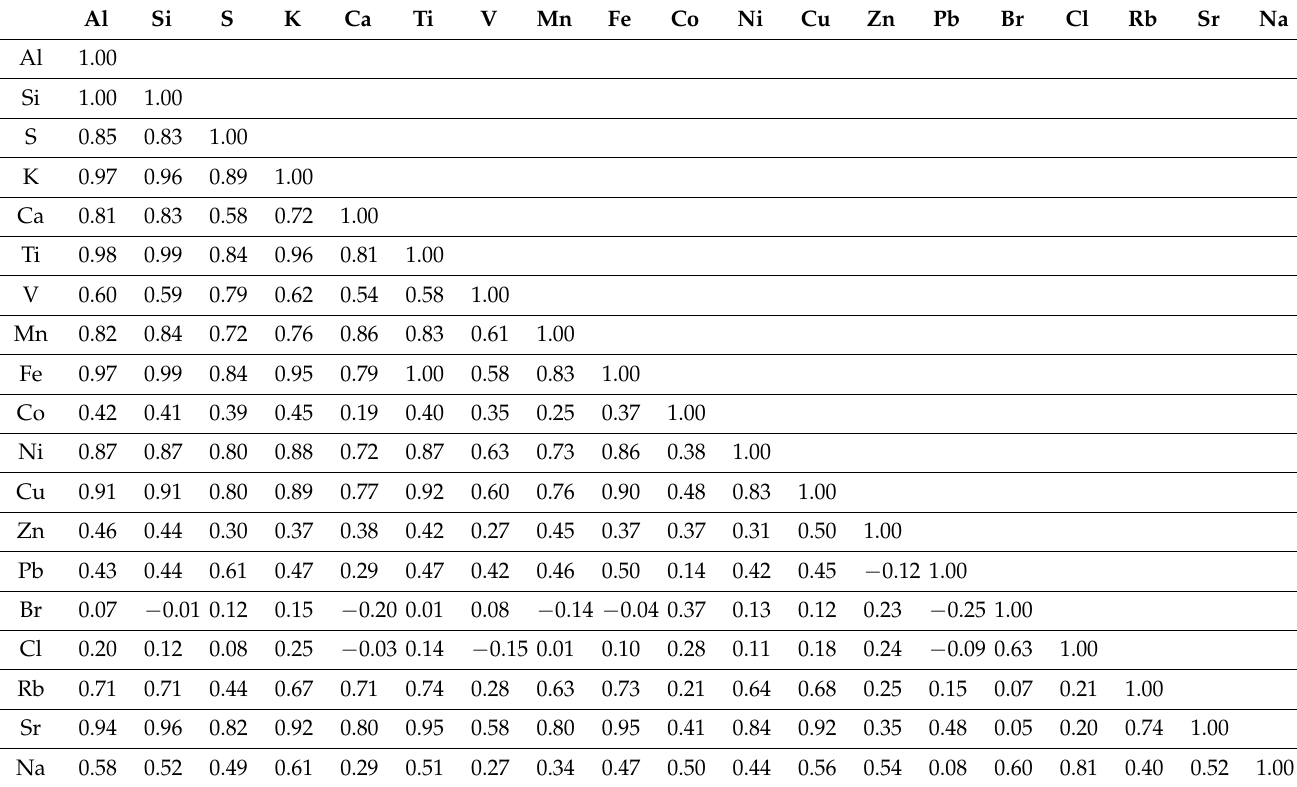
Table 3. The correlation coefficients of Pearson between the quantified elements in the PM 2.5 samples collected from historical Jeddah